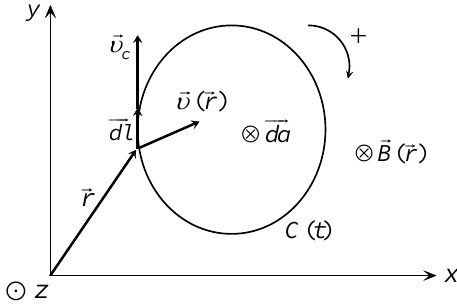
Figure 3: A wire C moving inside a static magnetic field.